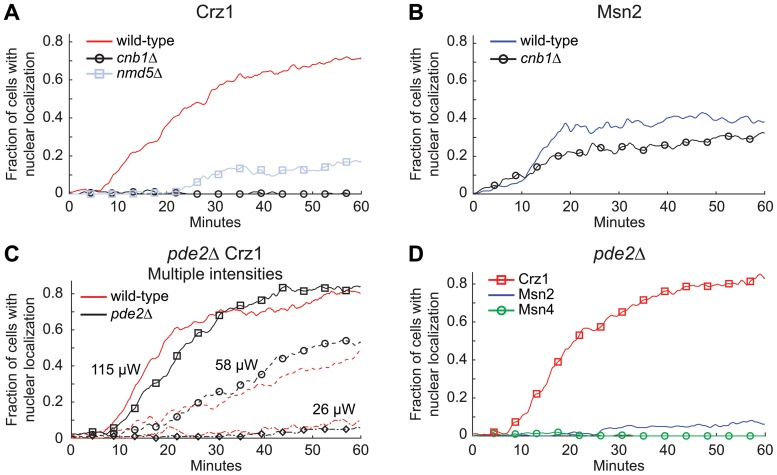
Transcription factor nuclear localization dependence on calcineurin and protein kinase A activity.(A) Fraction of cells with Crz1-GFP localized to the nucleus. In both cnb1Δ and nmd5Δ strains Crz1p nuclear localization was drastically reduced. (B) Fraction of cells with Msn2-GFP localized to the nucleus in a cnb1Δ strain. (C) Fraction of cells with Crz1-GFP nuclear localization in a pde2Δ strain at different light intensities (115 µW, 58 µW and 26 µW). (D) Fraction of cells with transcription factor nuclear localization in pde2Δ mutants (115 µW). Corresponding wild-type/reference experiments are shown for each sample set.